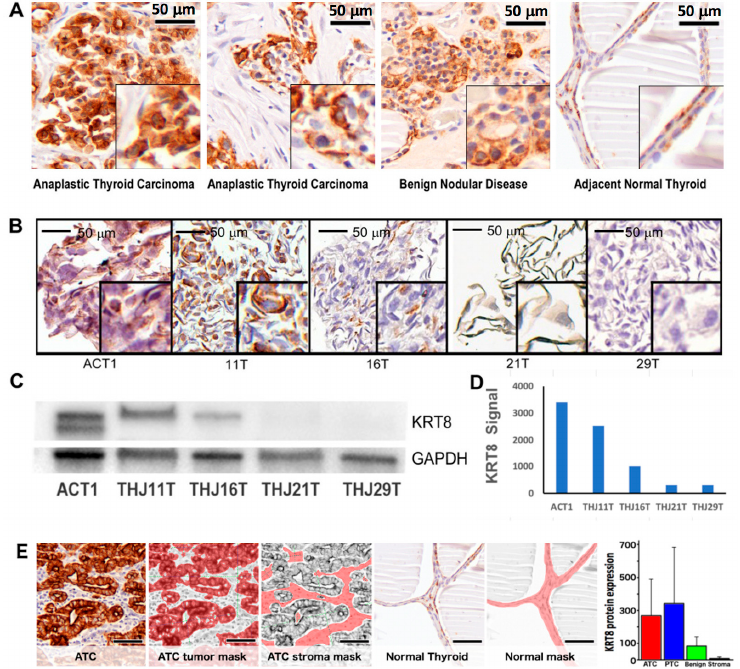
Figure 2. KRT8 is overexpressed in a subset of anaplastic thyroid carcinoma (ATC) tumors and cell lines. ( A ) There was elevated KRT8 expression in a subset of ATC tumors compared to normal thyroid and benign nodular disease by immunohistochemistry, and KRT8 expression was predominately cytoplasmic; ( B ) A similar heterogeneous KRT8 expression was observed in ATC patient-derived cell lines, with definitive expression in 3/5 and virtually undetectable expression in 2/5 ATC cell lines; ( C ) Immunoblot of lysates from these ATC cell lines using mouse monoclonal antibody specific for KRT8 demonstrated concordance with the immunohistochemistry data; ( D ) Semi-quantitative densitometry of these Western blot data, normalized for GAPDH and background signal; ( E ) Quantitative multispectral imaging of patient tumor and benign tissue (see methods) showed elevated KRT8 protein levels in ATC and papillary thyroid cancer (PTC) tumor tissue, compared to adjacent normal, tumor stroma, and benign nodular thyroid tissue. Scale bars in micrographs indicate 50 µ